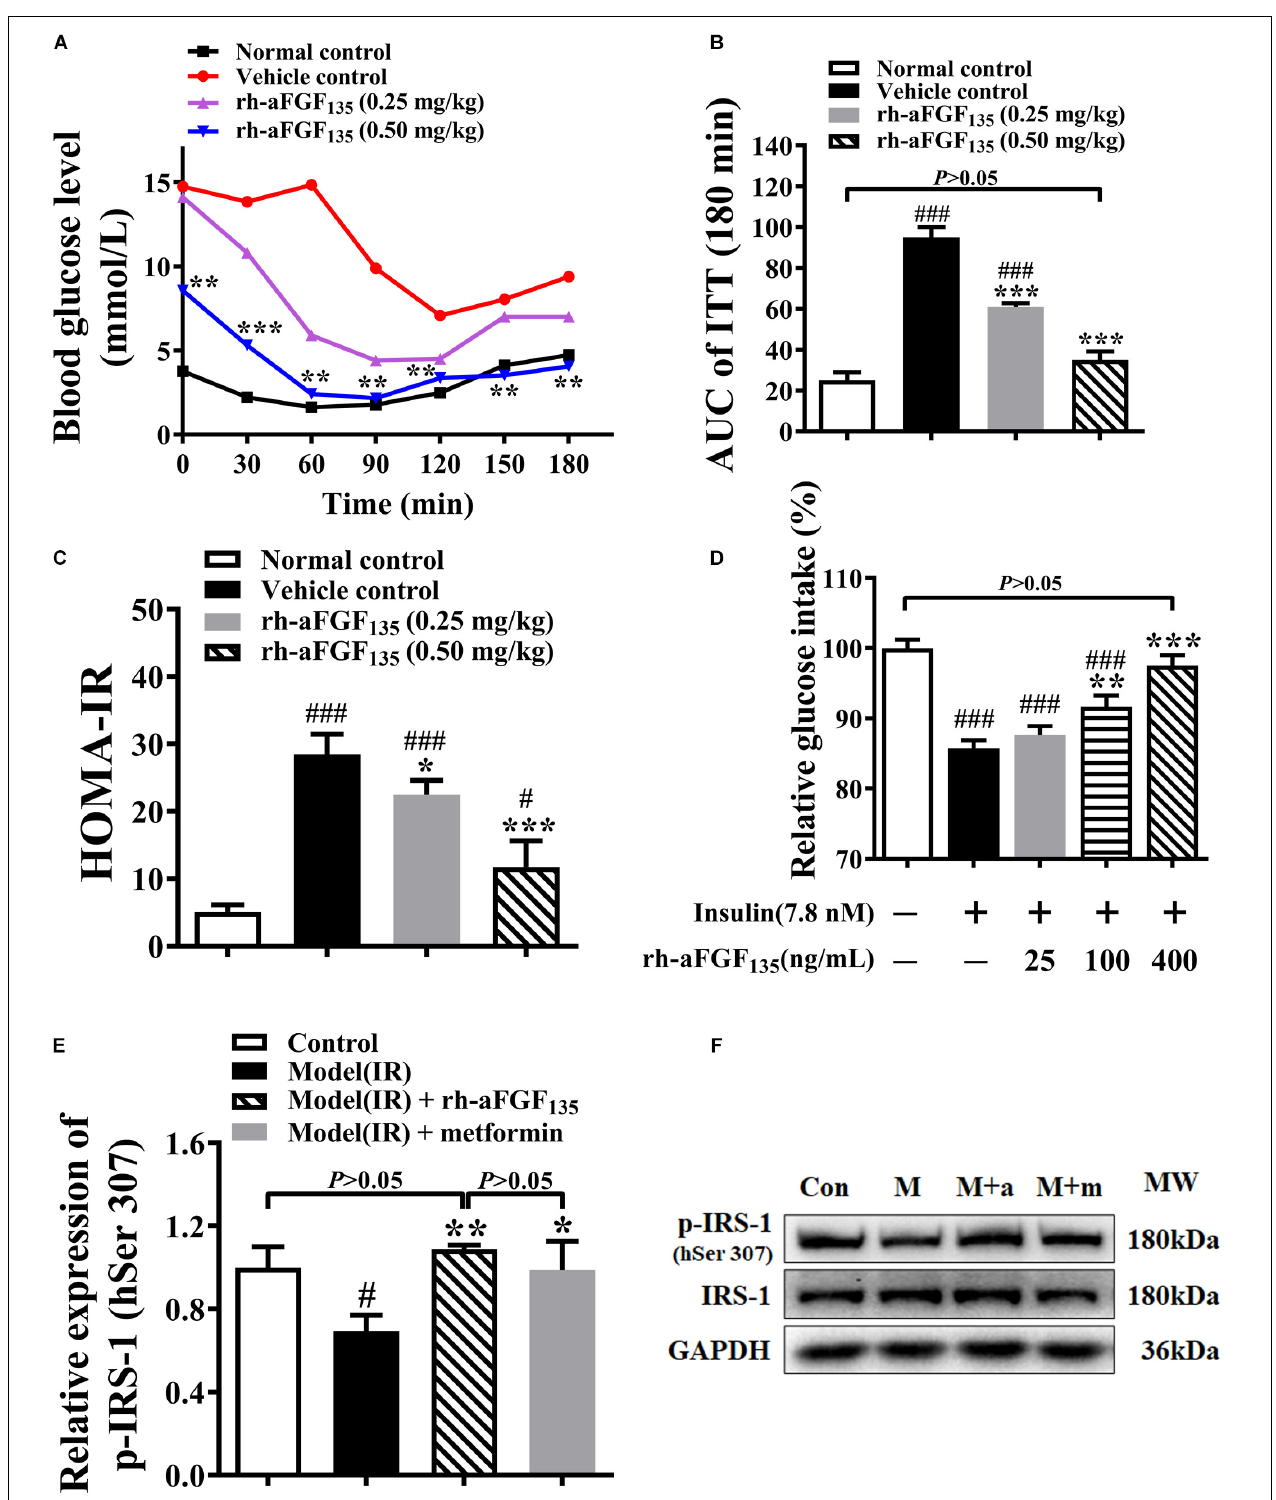
FIGURE 3 | Effects of rh-aFGF 135 on insulin resistance in diabetic ZDF rats and HepG2 cells. (A) Blood glucose levels in ITT in ZDF rats. (B) AUC value of ITT in ZDF rats. (C) HOMA-IR in ZDF rats. (D) Effect of rh-aFGF 135 on insulin resistance model in HepG2 cells. (E) Statistical analysis of relative expression of p-IRS-1 (human Ser 307, hSer 307) in HepG2 cells. (F) Western blotting of p-IRS-1 (human Ser 307, hSer 307) and IRS-1, Con: Control; M: Insulin resistance model; M + a: Insulin resistance model and rh-aFGF 135 (400 ng/mL); M + m: Insulin resistance model and metformin (0.5 mM, positive control). Compared to normal control, ### P < 0.001, # P < 0.05; Compared to vehicle control, *** P < 0.001, ** P < 0.01, * P < 0.05, n = 6.